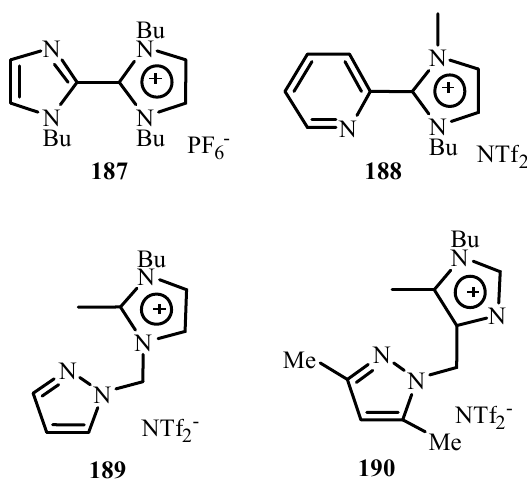
Figure 29. Charge ‐ tagged ligands (CTLs) reviewed by Limberger et al. [106].